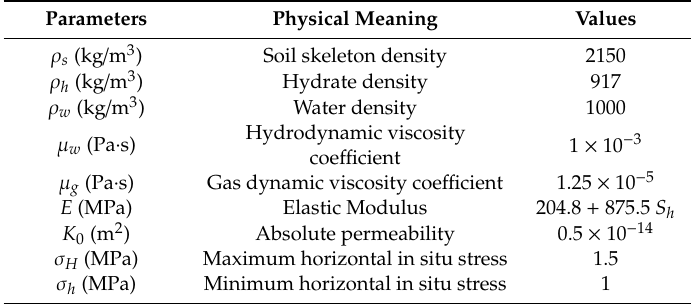
Figure 7. Diagram of the hydrate-bearing near-wellbore reservoir. Table 2. Physico-mechanical parameters of hydrate-bearing sediments.